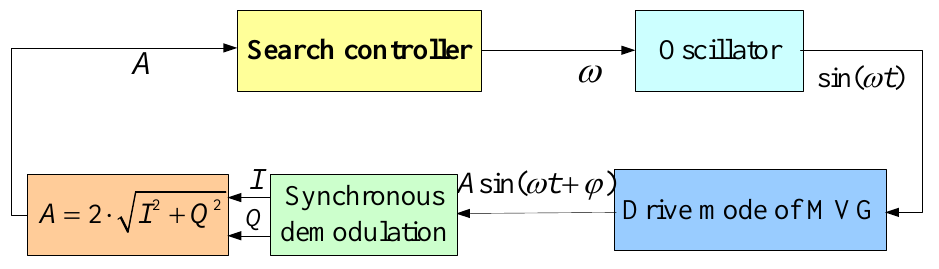
Figure 3. The block diagram of the proposed search method.